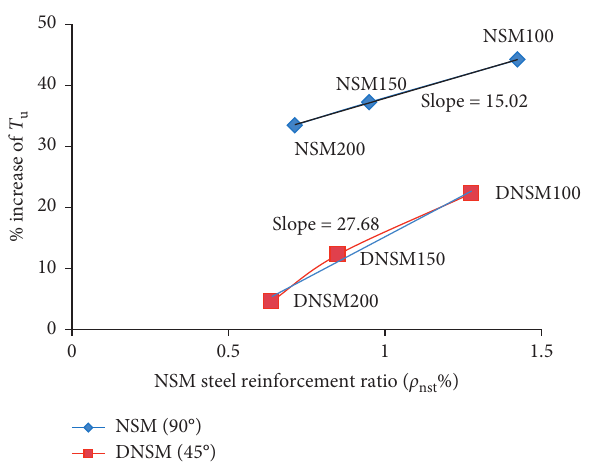
Figure 12: Influence of NSM steel reinforcement ratio on the torsional strength of concrete